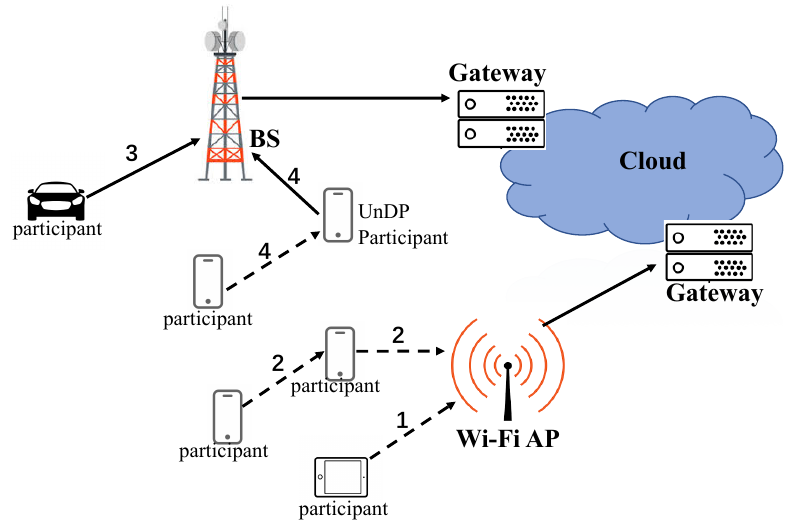
Figure 1. Data uploading